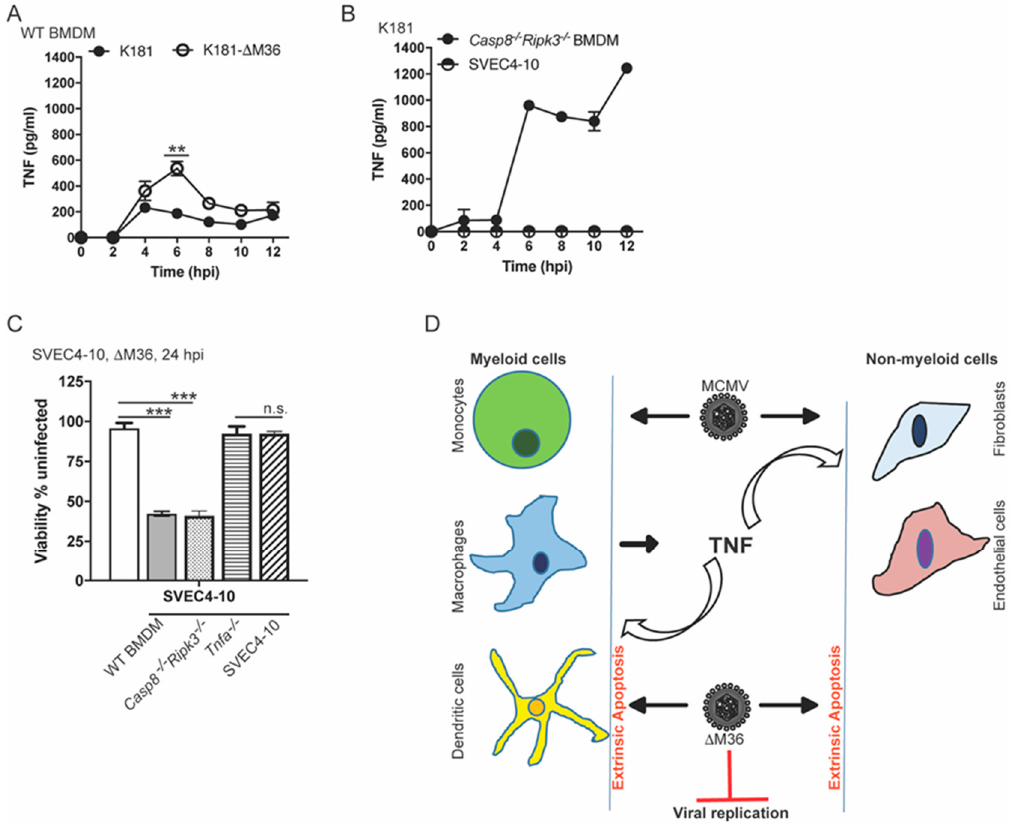
Figure 4. Macrophage-derived TNF drives ∆ M36-dependent apoptosis in endothelial cells. ( A , B ). TNF quantities in supernatant collected from K181- or ∆ M36-infected (MOI = 10) WT BMDM ( A ) and Casp8 − / − Ripk3 − / − BMDM or SVEC4-10 cells infected with K181 (MOI = 10) ( B ) over the indicated time course. Graphs reflect data pooled from one ELISA experiment analyzing data from 3 independent infection experiments each containing 2 replicates for all conditions. ( C ). Relative viability of untreated SVEC4-10 cells infected with ∆ M36 (MOI = 10) for 24 h and in absence or presence of supernatants collected at 6 hpi from ∆ M36-infected BMDM (WT, Casp8 − / − Ripk3 − / − or Tnfa − / − ) or SVEC4-10 cells. Untreated SVEC4-10 cells were infected for 1 h and then media or supernatants were added. Data are from one experiment with 3 replicates. ( D ). Model for MCMV and vICA mutant infection of myeloid (monocytes, macrophages, or dendritic) cells and non-myeloid (fibroblasts or endothelial cells). TNF is produced by myeloid cells that kill myeloid cells in an autocrine loop and non-myeloid cells in a paracrine loop. Lines above bars indicate the two groups compared for significance values using paired Student’s t-test where ** is < 0.01, *** is < 0.001, and n.s. represents nonsignificant.